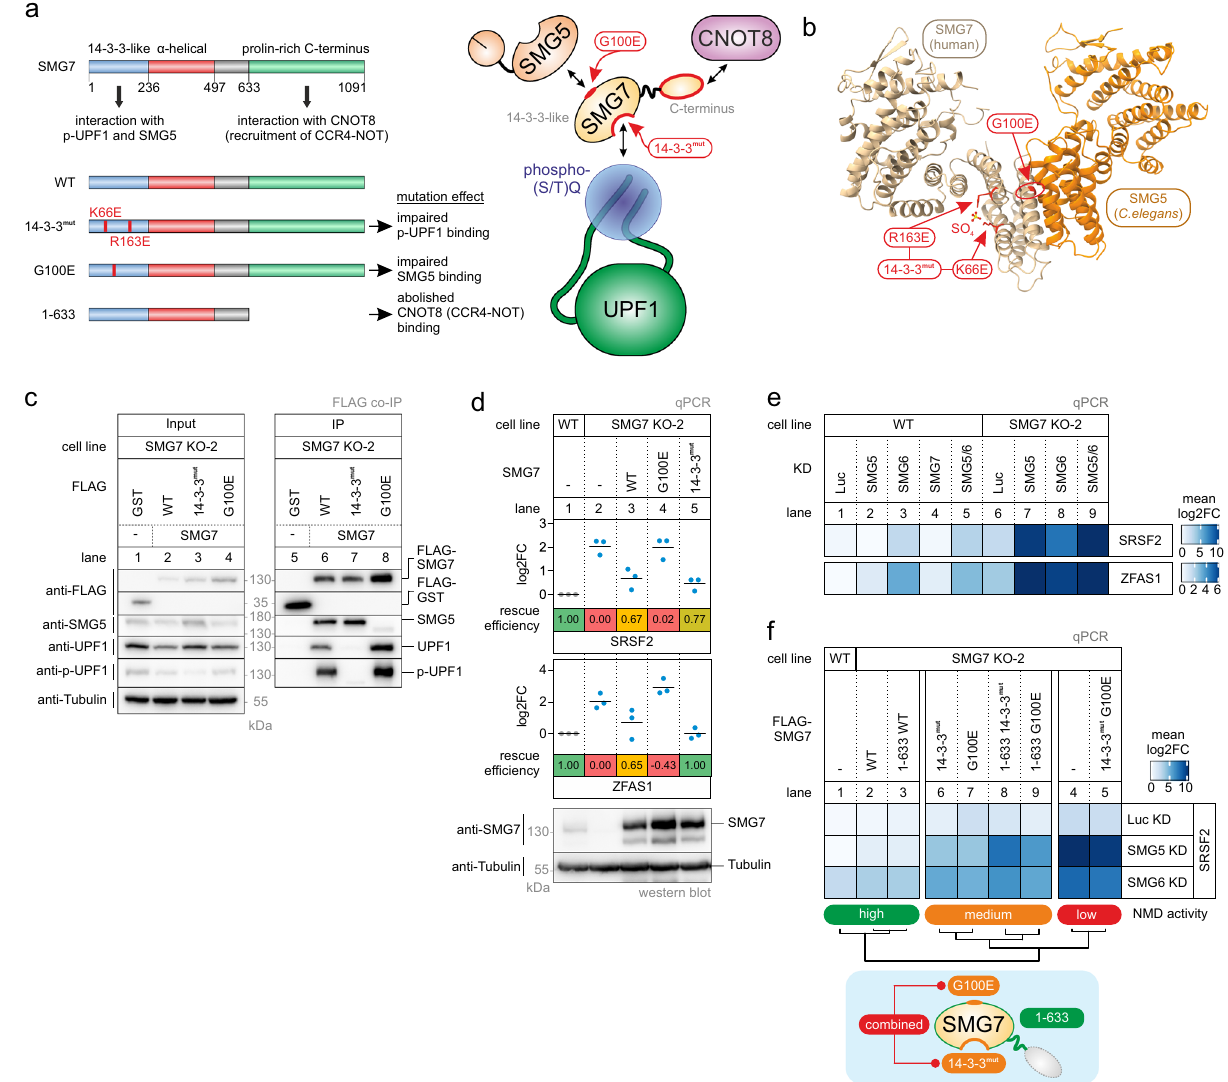
Fig. 2 SMG7 requires interaction with SMG5 to rescue the SMG7 knockout phenotype. a Schematic representation of the SMG7 domain structure on the left. The proposed functions of the domains are indicated and mutated constructs and their expected effect are shown below. The illustration on the right depicts which mutation is expected to impair which individual SMG7 function and/or protein-protein interaction. b Model of the SMG5-SMG7 heterodimer structure. Human SMG7 (PDB ID: 1YA0) was modeled on the C. elegans SMG5-SMG7 structure (PDB ID: 3ZHE). Critical SMG7 mutations are highlighted in red and the indicated sulfate ion mimics a phosphorylated residue. c Western blot after FLAG co-immunoprecipitation (IP) of FLAG-tagged GST (control) or SMG7 constructs in SMG7 KO cells ( n = 1). Tubulin serves as a control. d Quantitative RT-PCR-based detection (qPCR) of SRSF2 isoforms and ZFAS1 was carried out in the indicated cell lines upon expression of the indicated FLAG-tagged rescue constructs. The ratio of NMD isoform to canonical isoform (SRSF2) and ZFAS1 to the C1orf43 reference was calculated; data points and means from the qPCRs are plotted as log2 fold change (log2FC) ( n = 3 biologically independent samples). Rescue ef fi ciency was calculated based on the mean log2FC in relation lane 1 (set to 1) and lane 2 (set to 0). Western blot analyses are shown below ( n = 1). Tubulin serves as a control. e Heatmap of quantitative RT-PCR-based detection (qPCR) of SRSF2 isoforms and ZFAS1 in the indicated cell lines upon treatment with the indicated siRNA. The ratio of NMD isoform to canonical isoform (SRSF2) and ZFAS1 to the C1orf43 reference was calculated; mean log2 fold change (log2FC) is shown ( n = 3 biologically independent samples). The corresponding individual data points are plotted in Extended Data Fig. 3b. f Heatmap of quantitative RT-PCR-based detection (qPCR) of SRSF2 isoforms in the indicated cell lines upon treatment with the indicated siRNA and expression of the indicated FLAG-tagged rescue constructs. The ratio of NMD isoform to canonical isoform (SRSF2) was calculated; mean log2 fold change (log2FC) is shown ( n = 3 biologically independent samples). The corresponding individual data points are plotted in Extended Data Fig. 3c. Clustering ( k = 3) and functional summary of SMG7 mutations for NMD activity are depicted